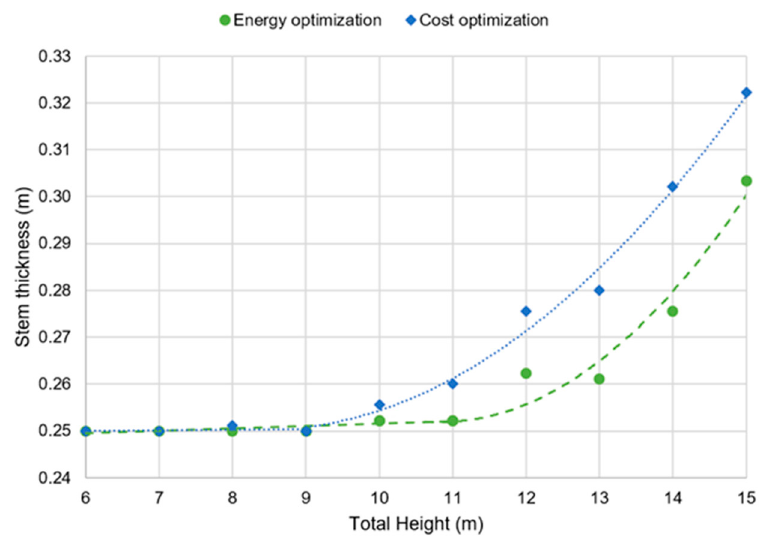
Figure 11. Relation between stem thickness and wall height.